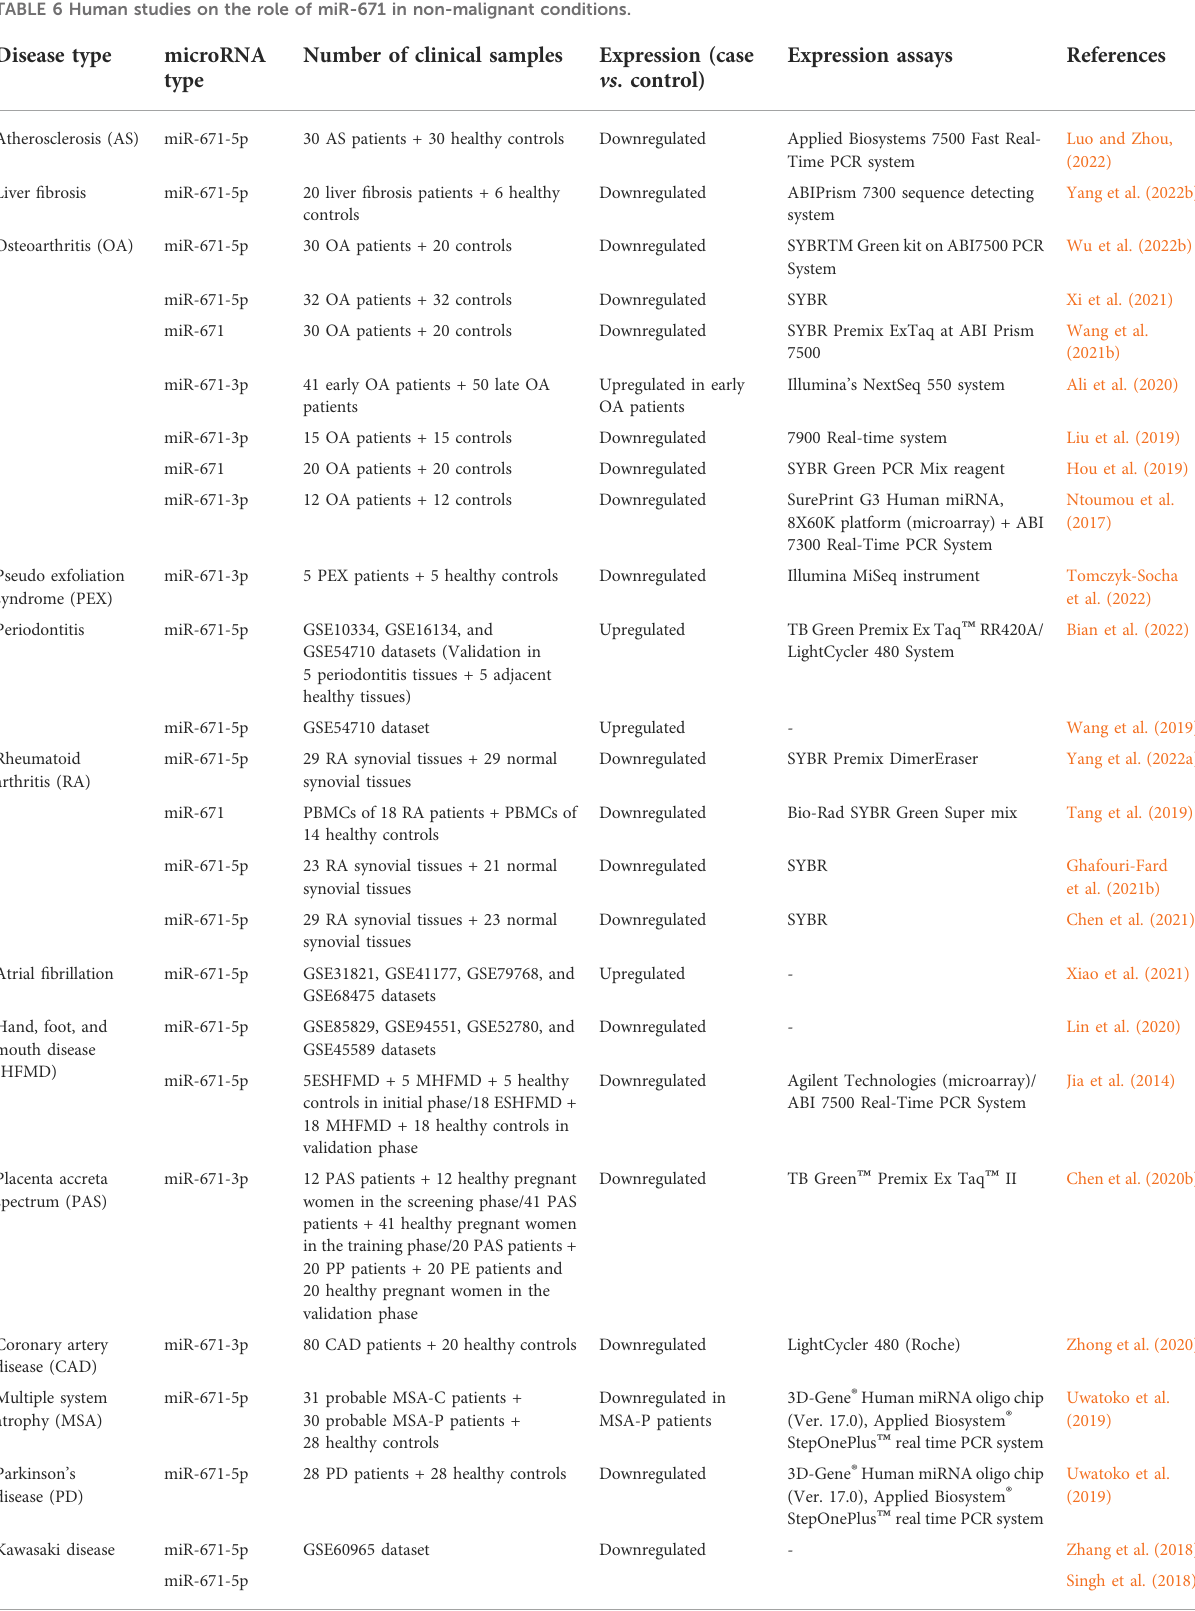
TABLE 6 Human studies on the role of miR-671 in non-malignant